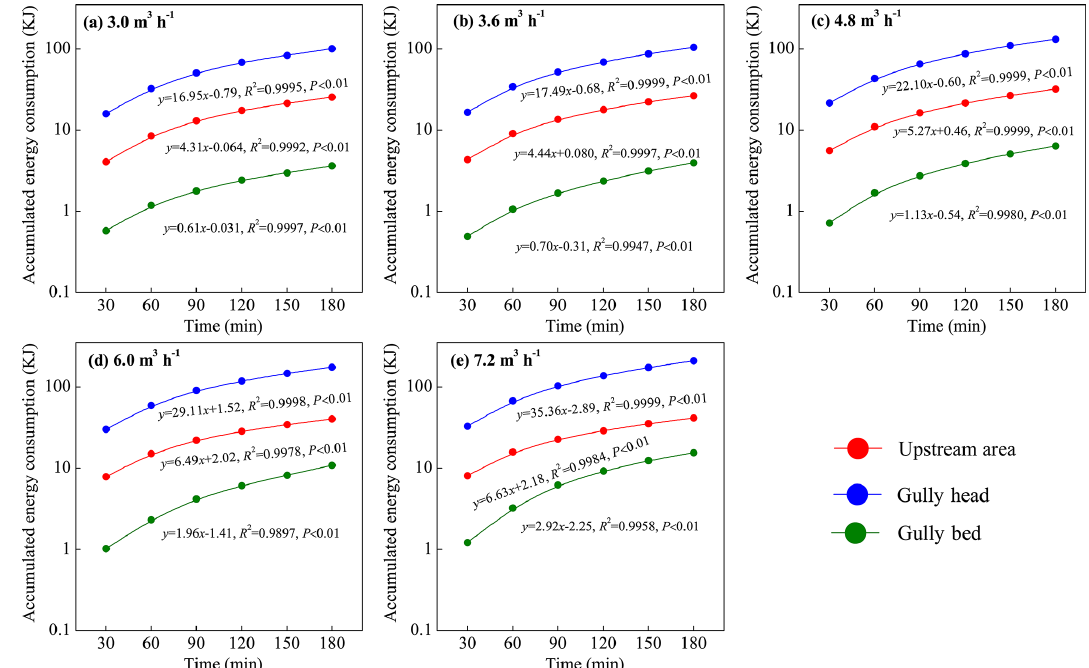
Figure 8. Temporal changes in runoff energy consumption of the upstream area, gully head, and gully bed under different inflow discharge